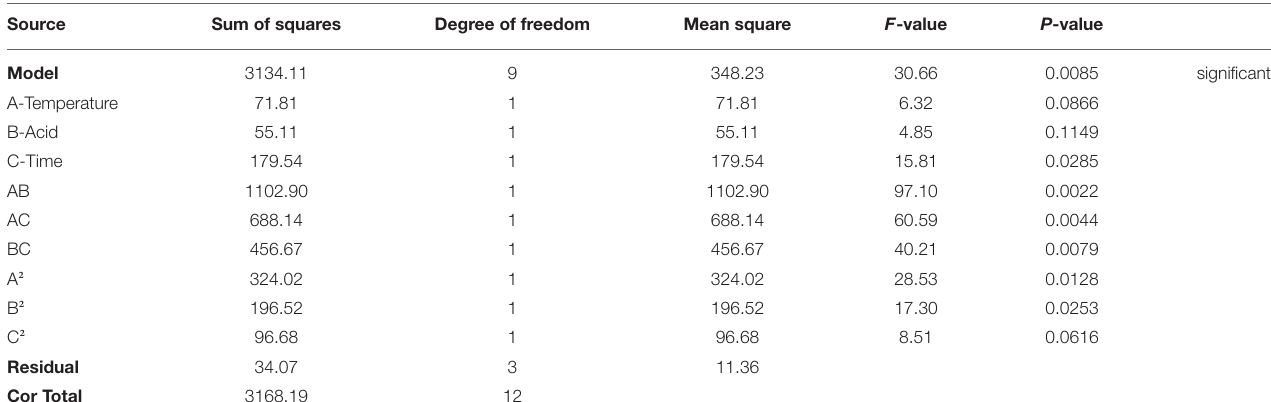
TABLE 2 | Analysis of variance in RSM